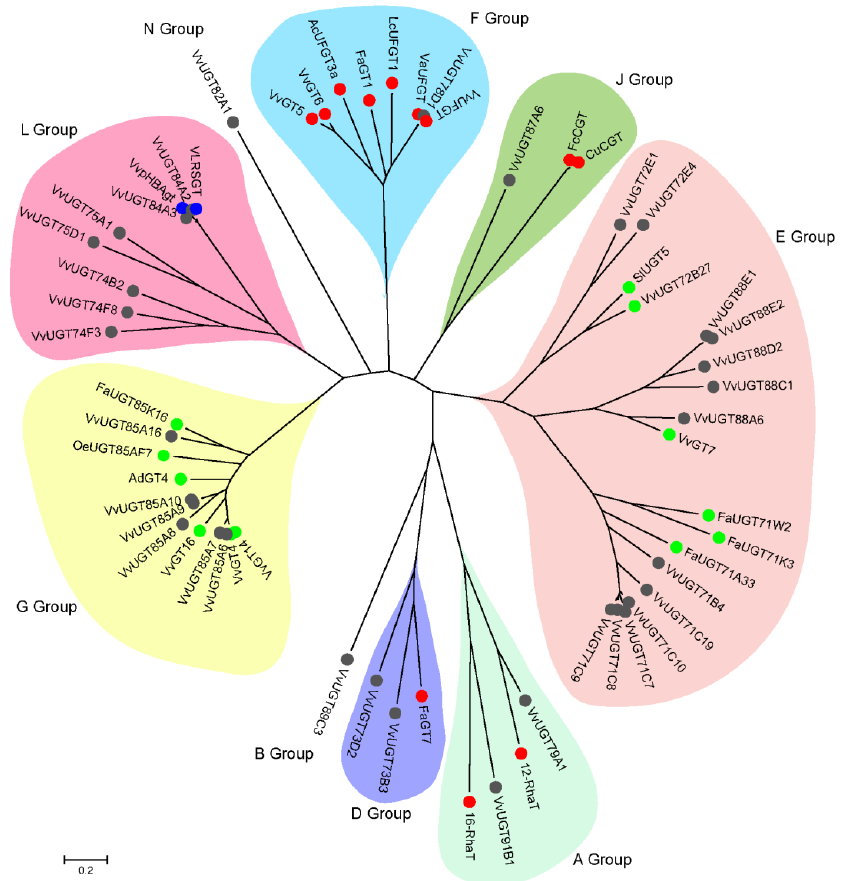
Figure 9. Phylogenetic analysis and functional classification of grape UGTs with other fruit trees. Grey dots represent grape UGTs. Red dots, green dots, and blue dots represent UGTs with identified functions related to the biosynthesis of flavonoids, GBVs, and stilbenes, respectively.